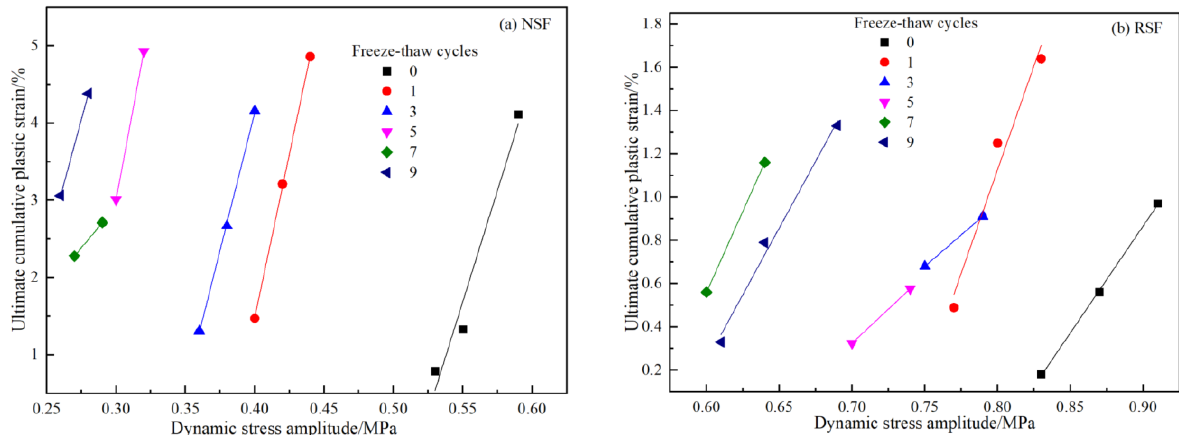
Figure 6. Ultimate CPS and dynamic stress amplitude curves ( a ) for NSF, ( b ) for RSF.